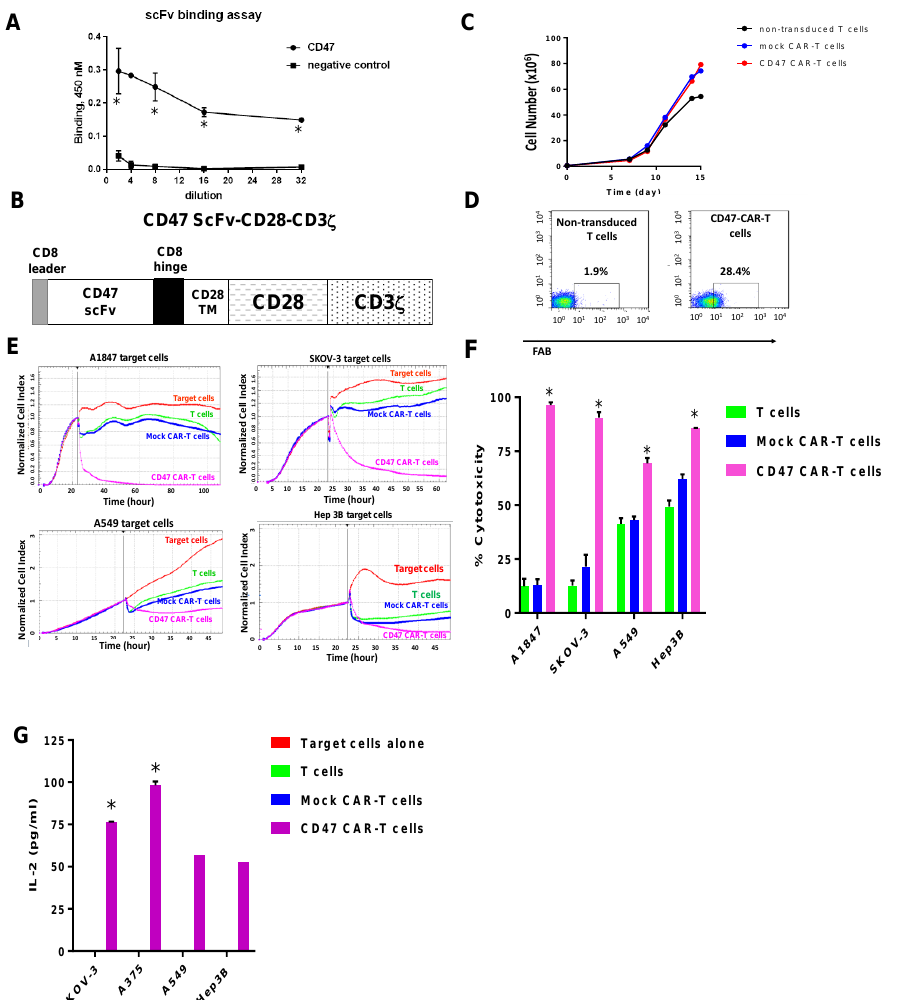
Figure 2. CD47 ScFv from mouse antibody binds CD47 and CD47-CAR-T cells effectively kill cancer cells in a CD47-dependent manner and produce IL-2. ( A ) ELISA binding analysis of CD47ScFv and CD47 antigen. Negative control CD49 antigen was used. There is significantly higher dose-dependent binding of CD47ScFv (B6H12) with CD47 antigen compared with negative control. * p < 0.05, Student’s t -test. Data are shown from two independent experiments; ( B ) The structure of CD47-CAR. The second generation CAR with CD28 co-stimulatory domain was used; ( C ) CD47 expansion in vitro. CD47-CAR-T cells expanded for >14 days similarly to control non-transduced T cells and Mock-CAR-T cells. Representative growth curve from two independent experiment is shown; ( D ) Expression of CD47-CAR in T cells transduced with lentiviral CD47-CAR by FACS with F(ab)2 antibody. T cells were effectively transduced with CD47-CAR. Expression of CAR is confirmed by FACS with F(ab)2 antibody and compared with negative control non-transduced T cells. Representative FACS data are shown from two independent experiments; ( E ) The Real-time cytotoxicity assay (RTCA) demonstrates that CD47-CAR-T cells kill CD47-positive cancer cells more significantly than CD47-low expression cancer cells; ( F ) Cytotoxicity of CD47-CAR-T cells versus T cells and Mock-CAR-T cells. The quantitation of RTCA from three independent experiments is shown. * p < 0.0001 CD47-CAR-T cells versus T cells and Mock CAR-T cells by 2-way ANOVA with Tukey’s post-test. G. CD47-CAR-T cells produce IL-2 in a CD47-dependent manner; high in CD47-positive cells and lower in CD47-negative cells. The Effector to target E:T ratio was 1:1. The bars show average IL-2 secretion by CD47 CAR-T cells from two independent experiments. * p < 0.05, Student’s t -test in SKOV-3 and A375 cells versus T cells, Mock CAR-T cells, A549 cells and Hep 3B